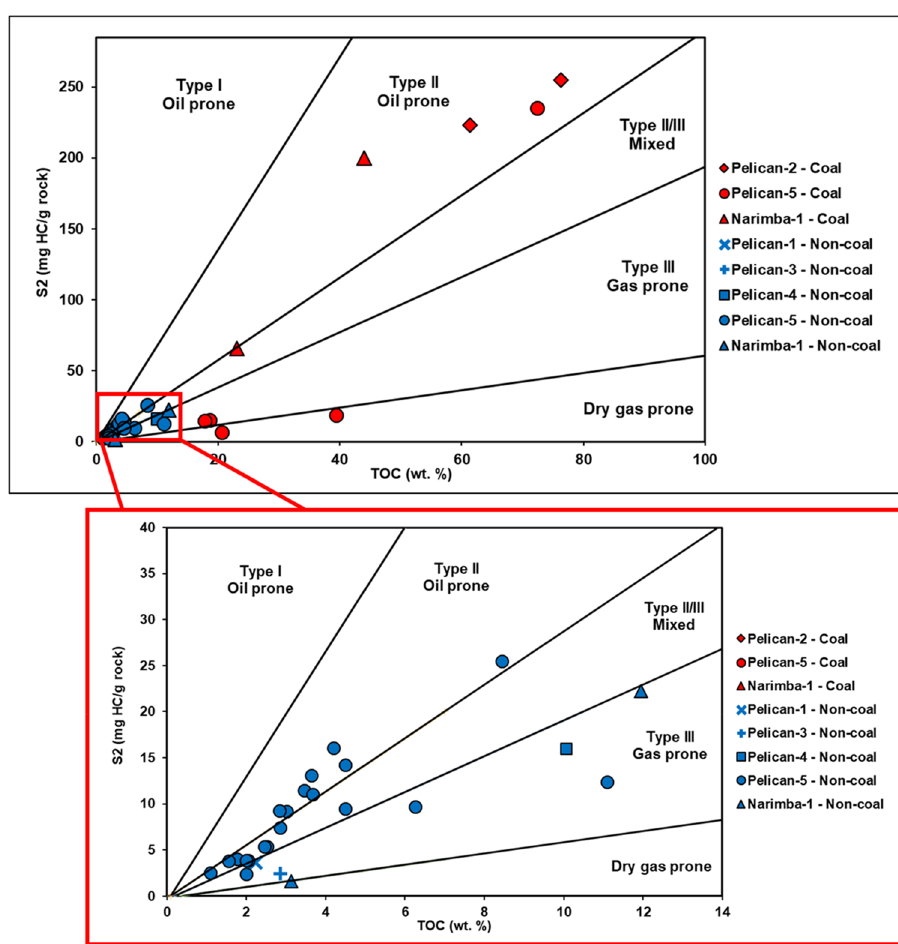
Fig. 7 S 2 versus TOC cross-plot to identify kerogen typing of organic matter (Langford and Blanc-Valleron